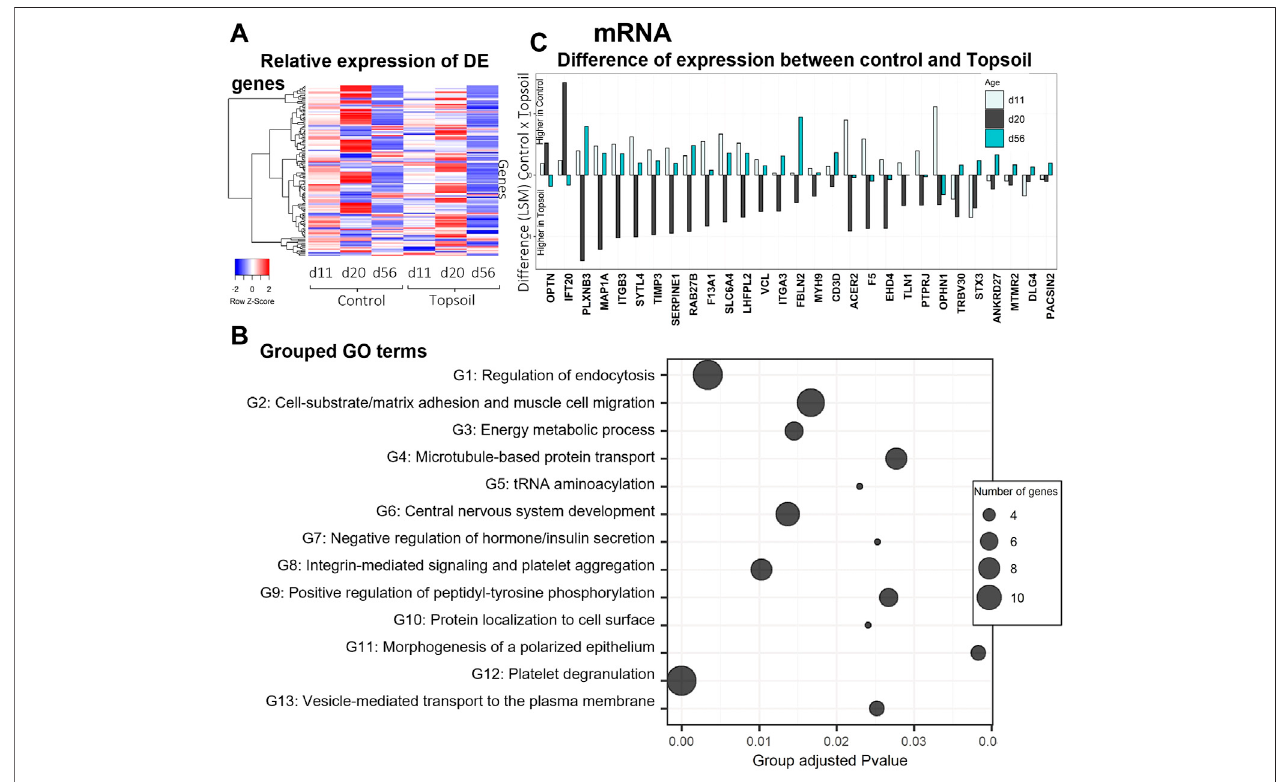
FIGURE1| Geneexpressionandgeneontology(GO)enrichmentanalysisofthedifferentiallyexpressed(DE)mRNAinresponsetotopsoiltreatment (A) Aheatmap comparison of the expression of the DE mRNAs across time and treatment (control vs. topsoil) in peripheral blood mononuclear cells (PBMCs.). The three timepoints correspondtowhenpigswerestillexposedtotopsoilinthenursery(d11)andatweaning(d20)aswellasaftertopsoilwasremovedatthepostweaning(d56)timepoint. The heat map shows the clustered relative gene expression (least squares mean – LSM) for control and topsoil treatments by age (day of life/age of piglet: 11, 20, and 56) (B) Visualization of the number and signi fi cance of grouped gene ontology (GO) terms identi fi ed using the DE genes in ClueGo software. The group